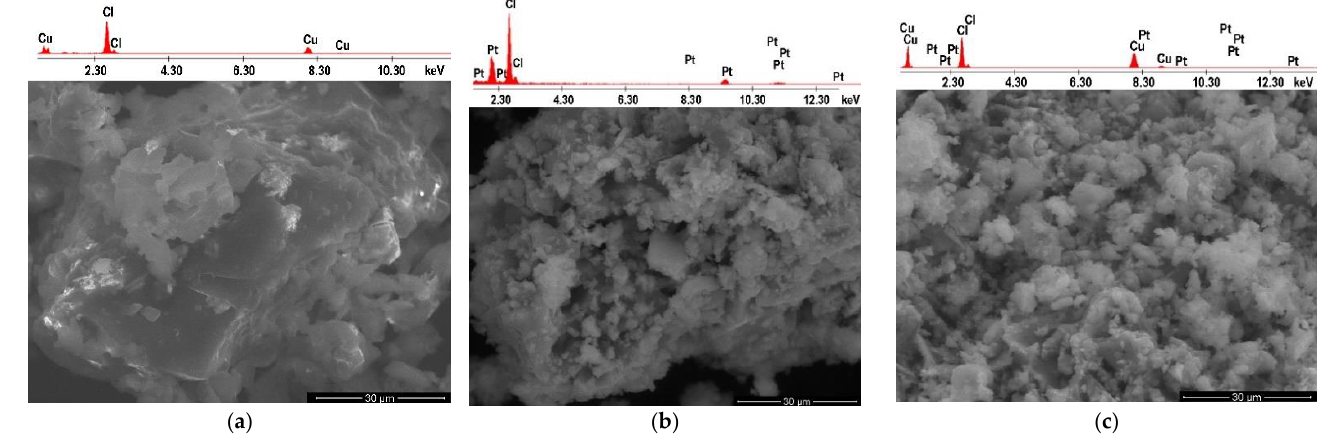
Figure 10. SEM images with EDAX in detail for: ( a ) CuNPs; ( b ) PtNPs; ( c ) Pt@CuNPs.